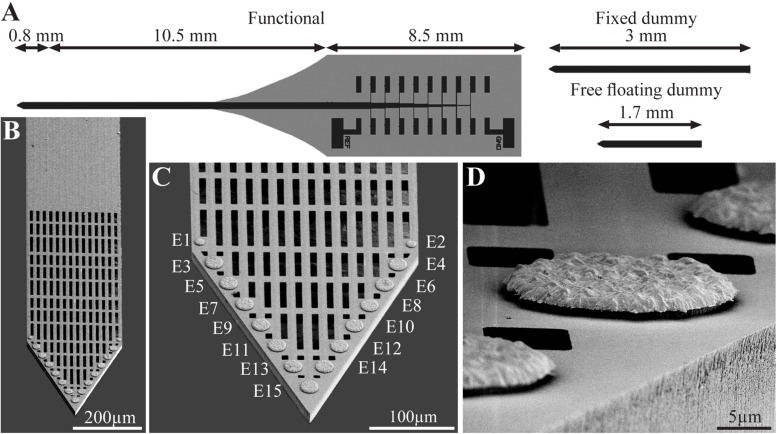
The perforated polyimide based MEA platform (PPMP). (A) Schematic drawing of the functional PPMP (left hand side), fixed and free floating dummy implants (right hand side). The functional PPMPs were constructed of single 280 μm wide and 16 μm thick shanks. The shanks were subdivided into a 0.8 mm long distal perforated part and a 10.5 mm solid proximal part. Gold interconnects, insulated by a PI layer, terminated by output pads at the proximal end of the shaft. (B) Scanning electron microscope image of the perforated and solid parts of a PPMP shank. (C) Enlargement of the platform tip carrying 15 planar electrodes. (D) Enlargement of a planar gold electrode.